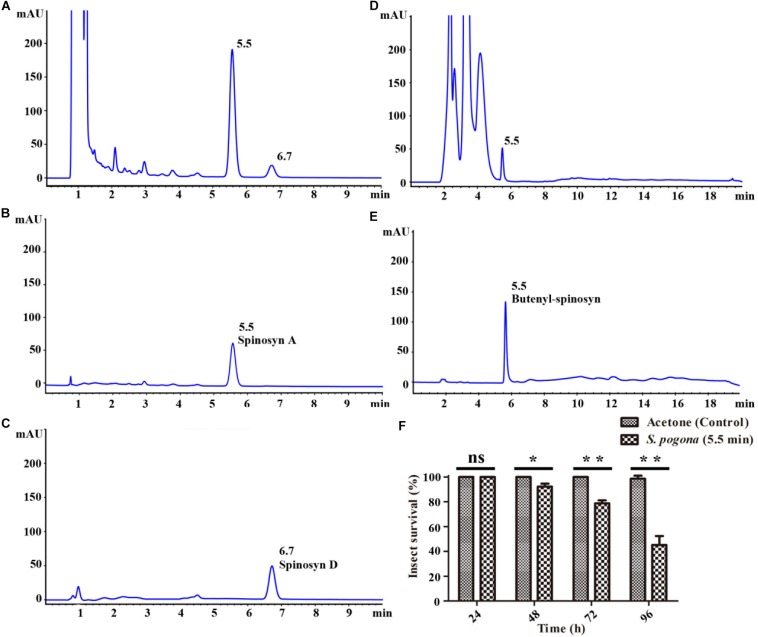
HPLC analysis of spinosyn and butenyl-spinosyn. (A) Fermentation broth of wild-type strain S. spinosa. (B) Standard spinosyn A. (C) Standard spinosyn D. (D) Fermentation broth of wild-type strain S. pogona. (E) Purified butenyl-spinosyn. (F) Analysis of insecticidal activity of H. armigera of the eluent collected at 5.5 min. *p < 0.05, **p < 0.01, ns, no significant.